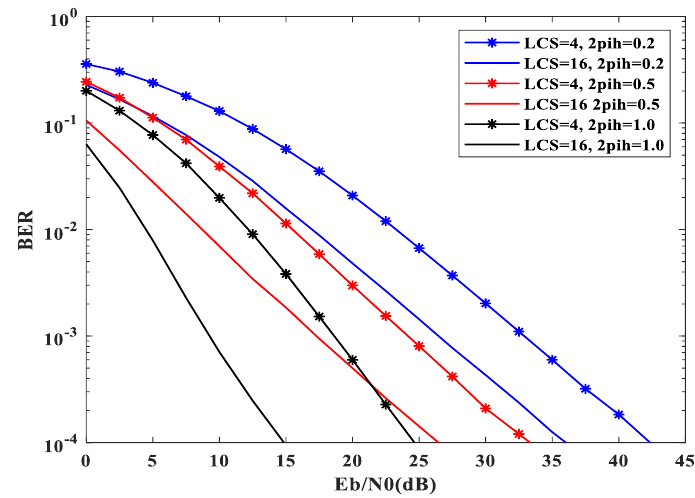
Figure 12. Impact of length of code sequence LCS on the performance of the PM-OFDM-CDMA